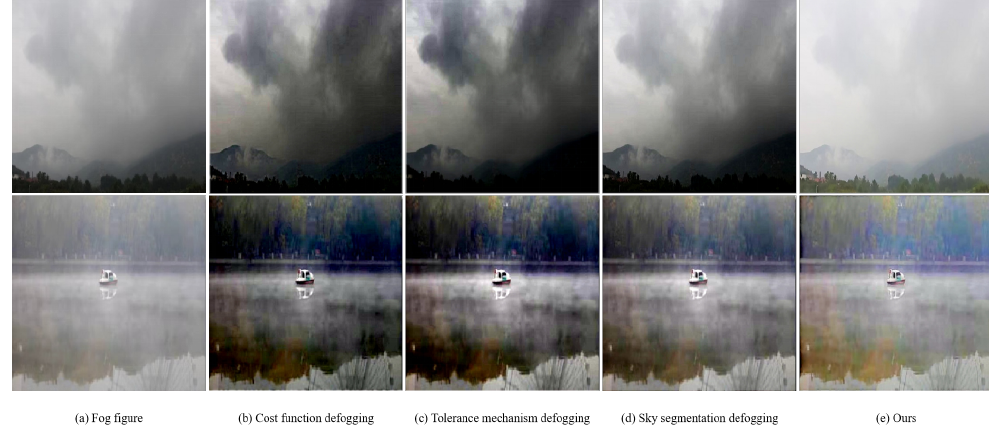
Figure 7. Comparison of the effect of different defogging algorithms, including cost function de- fogging algorithm [16], tolerance mechanism defogging algorithm [12], and sky segmentation algo- rithm [15], on defogging in bright